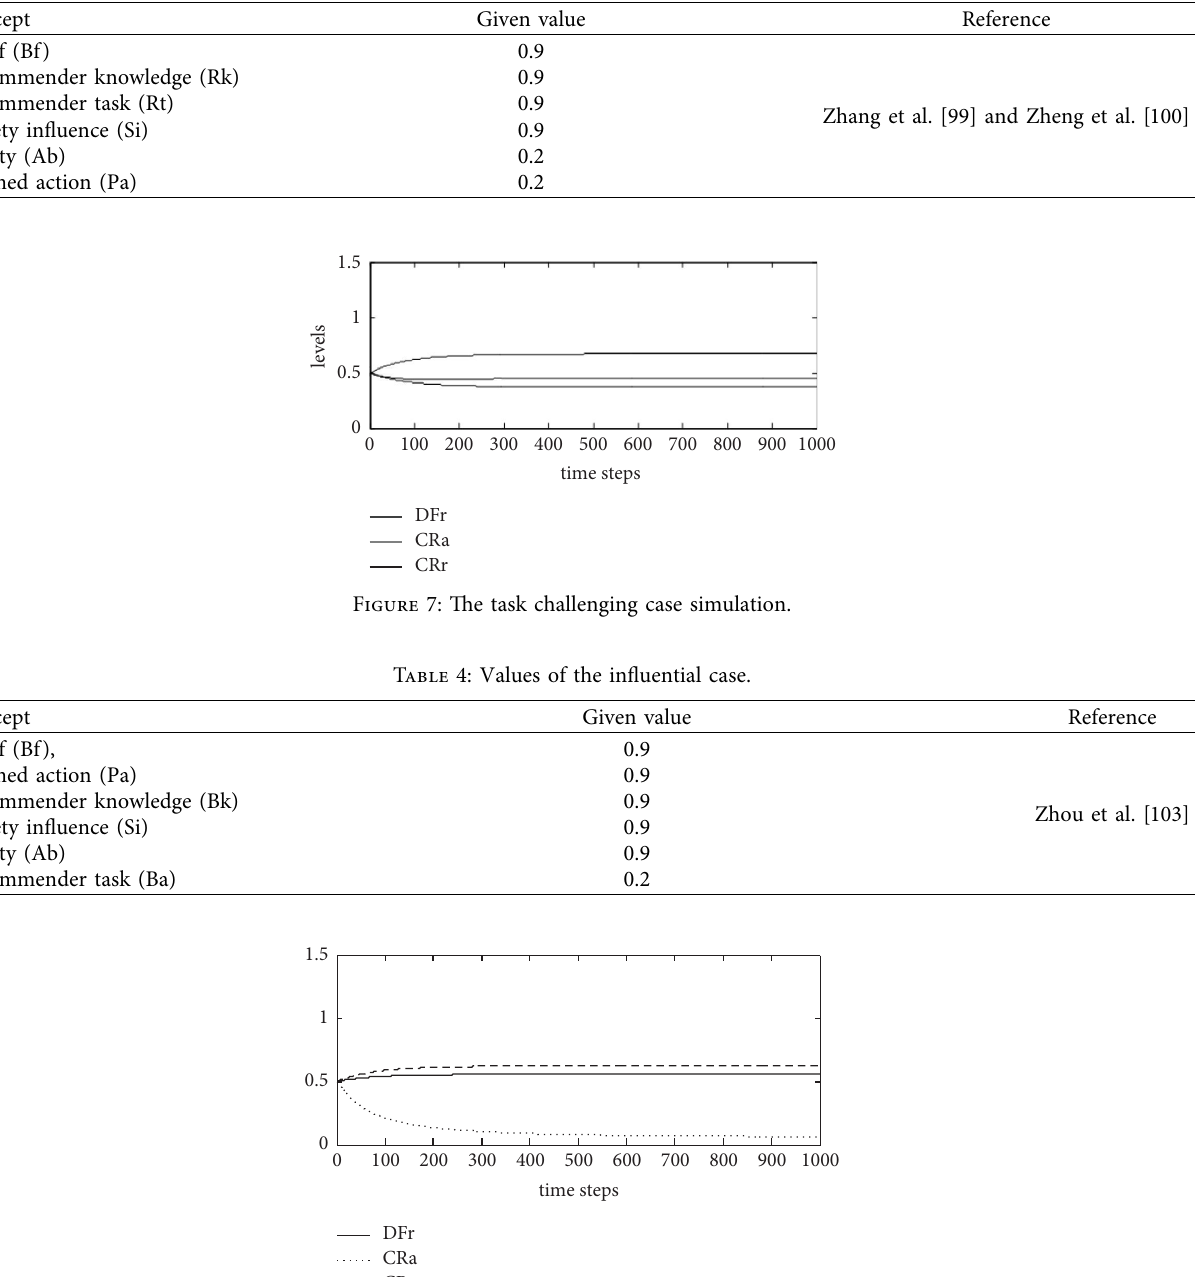
Table 3: Values of task challenging case